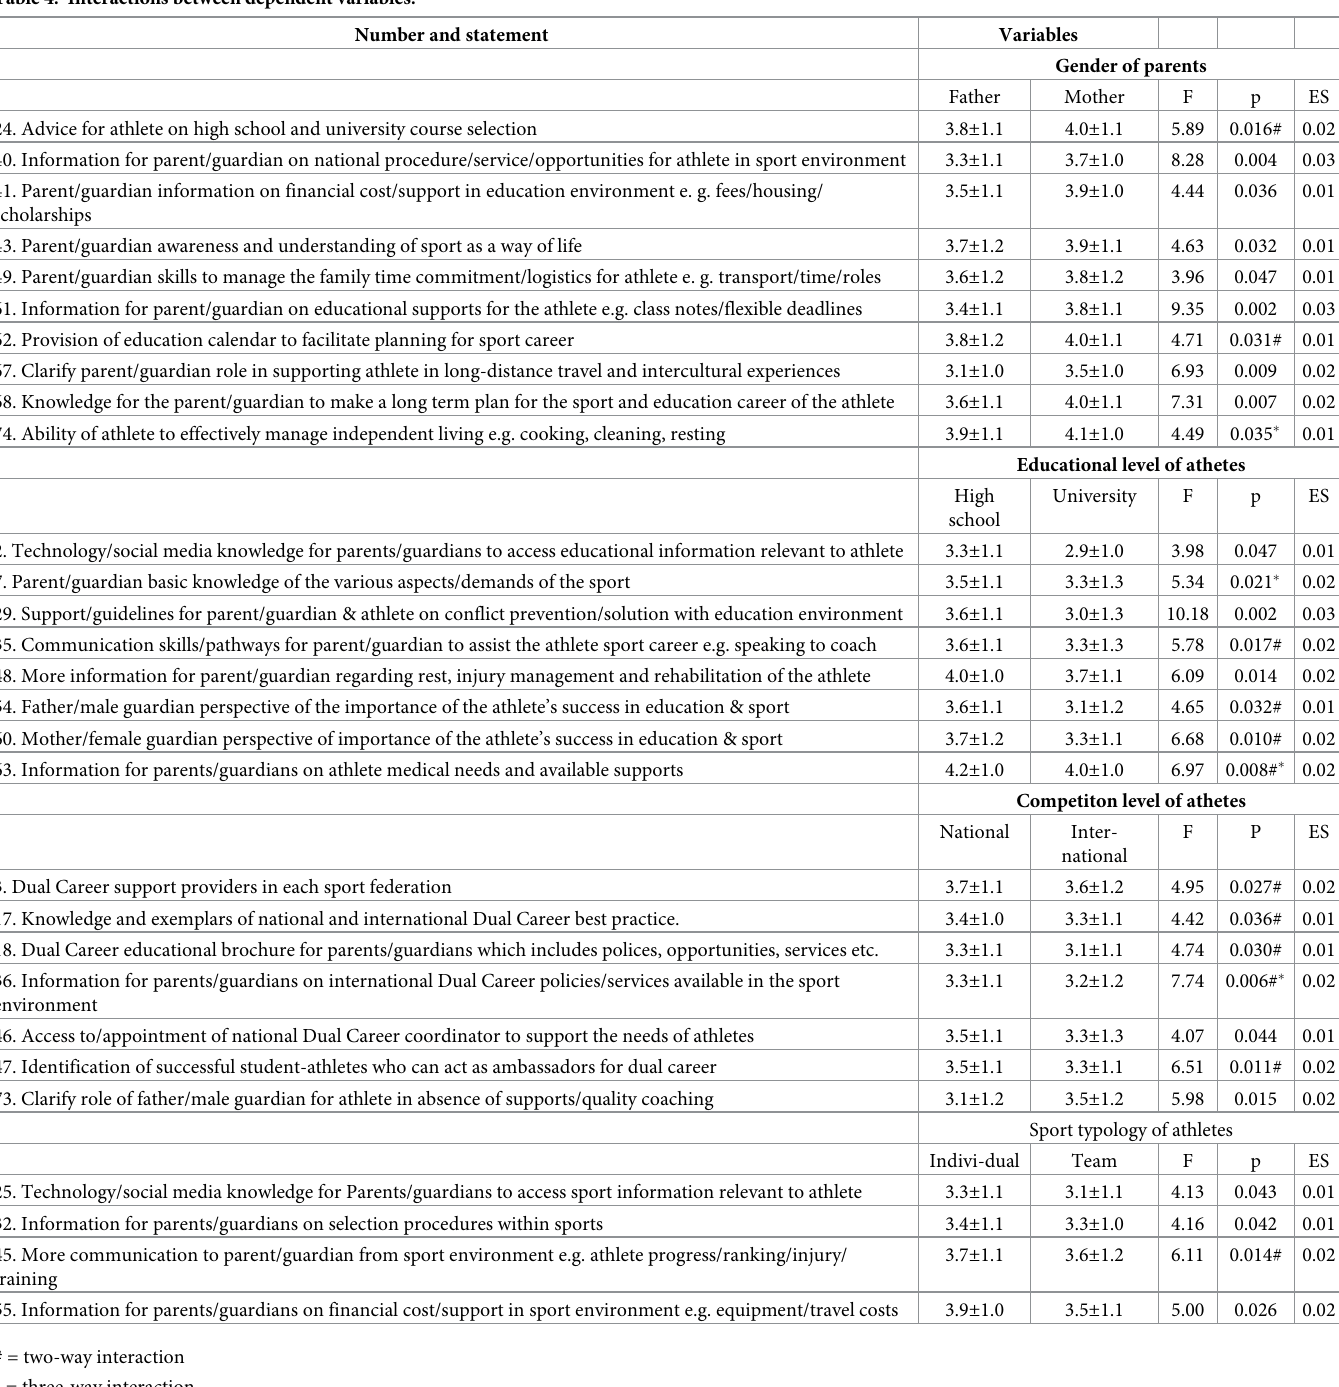
Table 4. Interactions between dependent